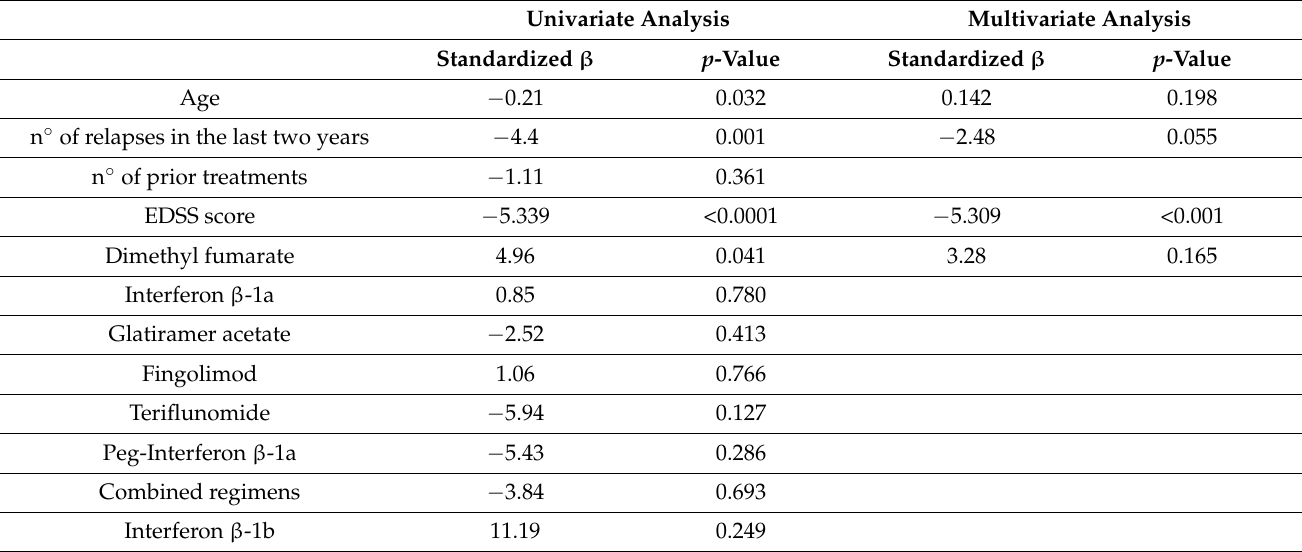
Table 4. Univariate and multivariate linear regression analysis: standardized Beta coefficients of independent variables and p -values assessed for Mental Health Composite